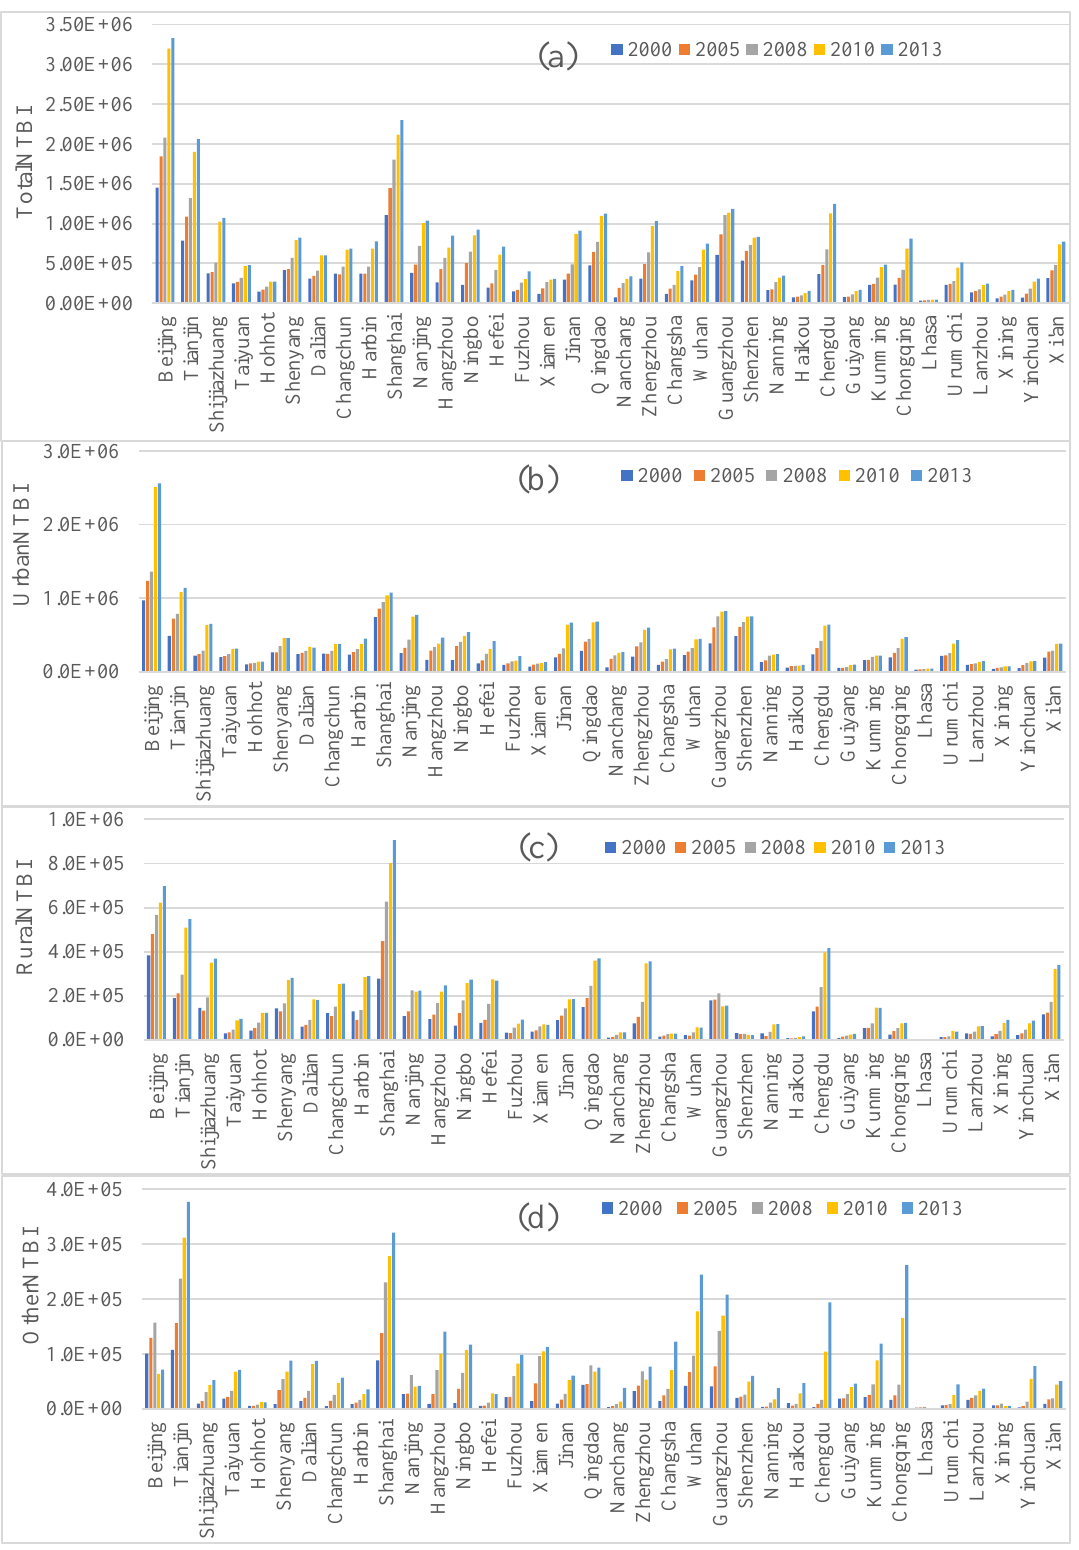
Figure 4. Trends in ( a ) TotalNTBI associated with total developed land area, ( b ) UrbanNTBI associated with urban developed land area, ( c ) RuralNTBI associated with rural developed land area, and ( d ) OtherNTBI associated with other developed land area, within the cities’ boundaries in 2000–2013 characterized with a cumulative unitless DN value (CUDV).